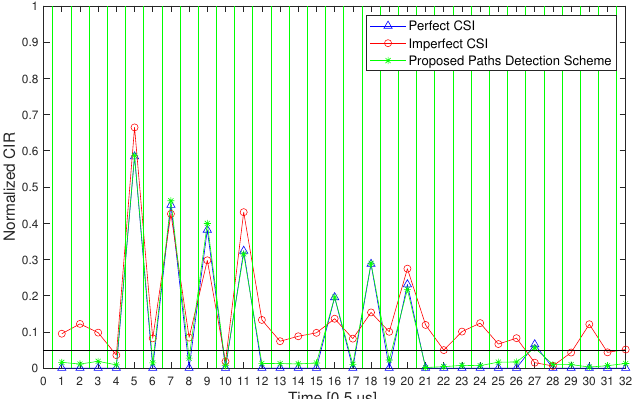
Figure 12. CIR variation in the proposed scheme, as well as for the perfect and imperfect CSIs.